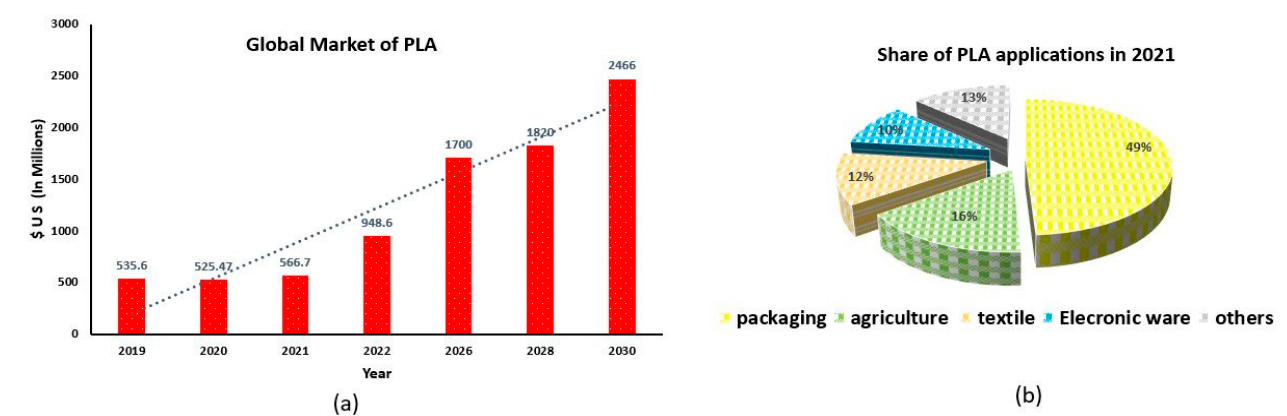
Figure 11. Showing ( a ) forecasted trend of global market size of PLA and ( b ) weightage of various PLA applications in 2021 [214].